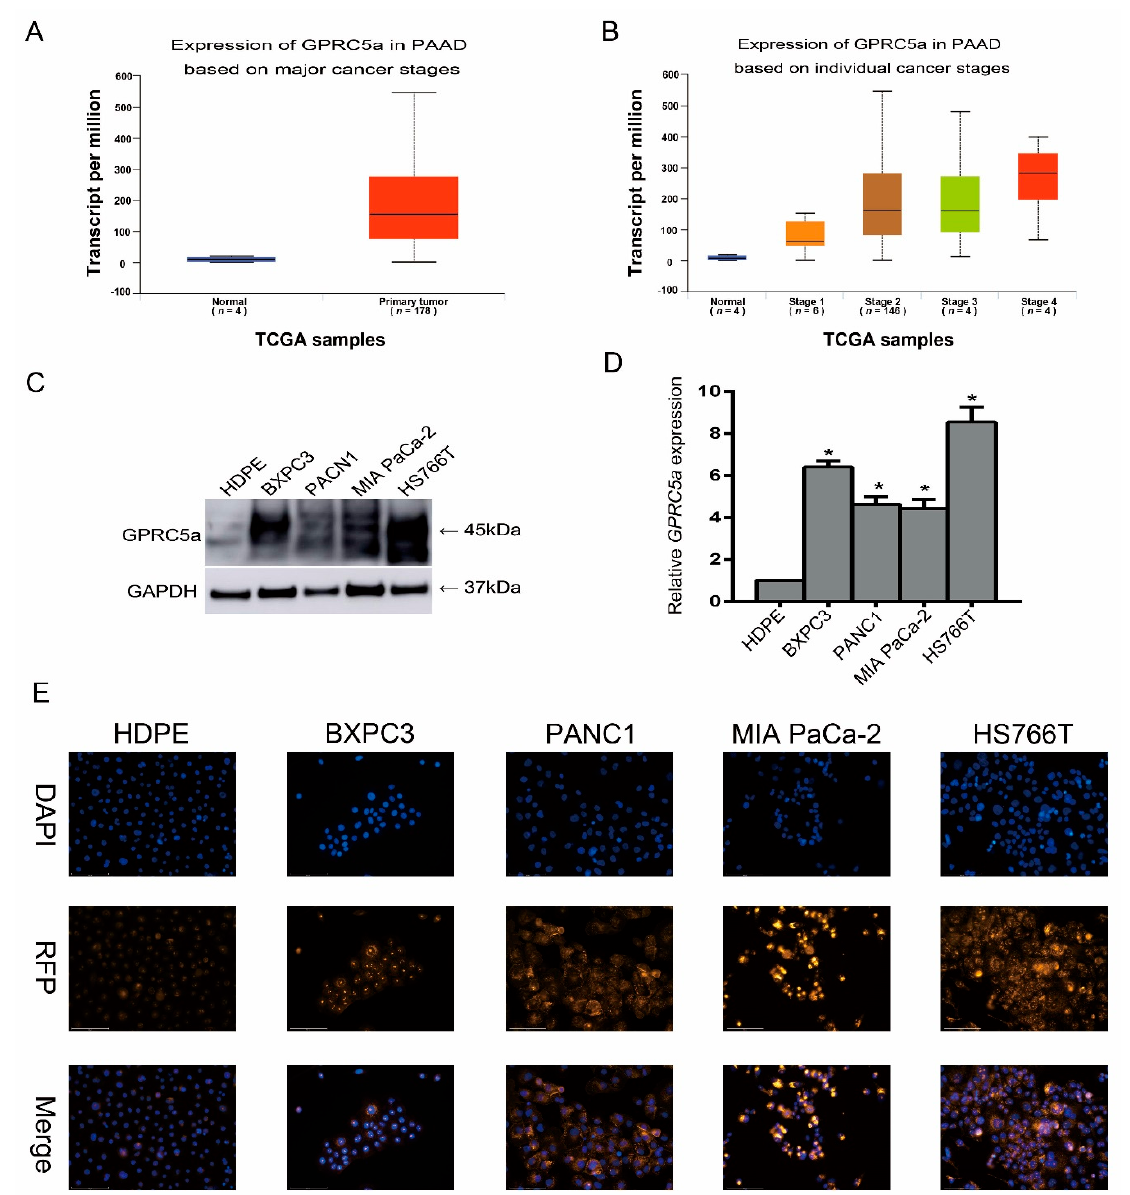
Figure 2. GPRC5a expression levels in normal pancreas and PaCa (PAAD) tissue and cell lines. ( A , B ) The data-mining analysis showed that GPRC5a was significantly upregulated in PaCa (PAAD) samples with an association of increased expression in higher malignant tumor stages ( p < 0.05). ( C , D ) The Western blot and qPCR results showed that the basic protein-level expression of GPRC5a in PaCa cell lines was higher than that in the HPDEE6E7 pancreas cell line. ( E ) Immunofluorescence assay showed upregulated expression of GPRC5a in PaCa cell lines (200 × ). The error bars were from multiple samples ( n ) measurement results ( A , B ) or three experimental measurements ( C , D ). * p -value < 0.05.